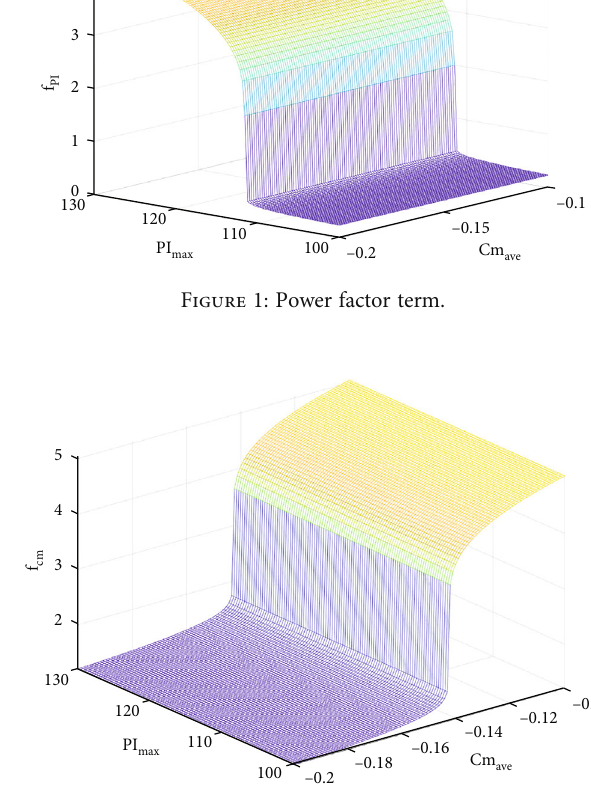
Figure 2: Pitching moment term.